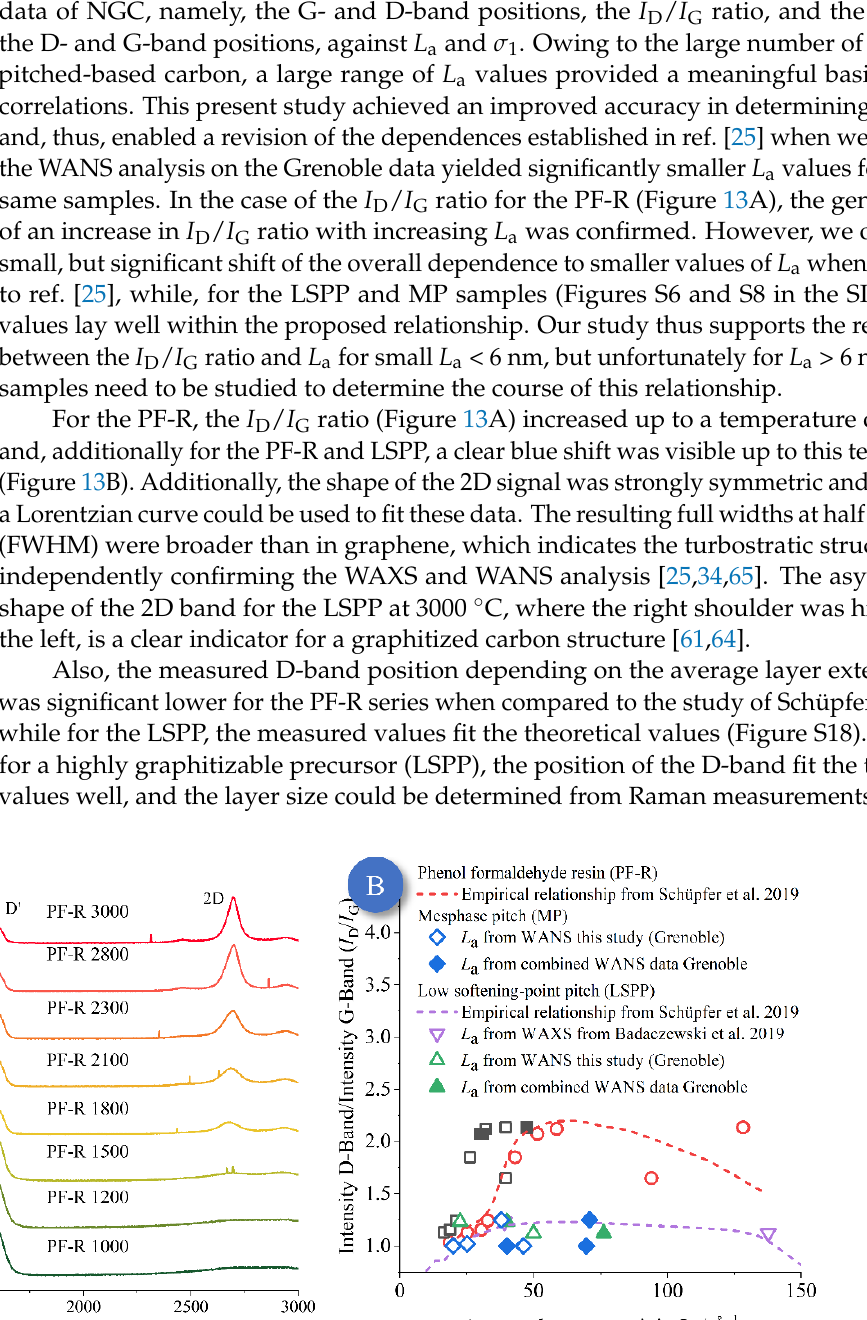
Figure 13. ( A ): Raman spectroscopy data for the phenol-formaldehyde resin-based carbons (PF-R) for different treatment temperatures, using an excitation wavelength of 633 nm. All samples showed increasing 2D and D’ bands and a higher G/D ratio at higher heat treatment temperatures, which are clear indicators for the increase in layer extension and decrease in disorder at higher temperatures [24,25]. ( B ): The intensity quotients I D / I G values were previously determined by Schüpfer et al. [25] and compared to the different L a values determined in this present study and in the work of Badaczewski et al. [37]. ( C ): The position of the D-band was lower than the theoretical values for these resins as determined in ref. [25], indicating that, for (disordered) glass-like carbon, such a theory may not be applicable. ( D ): Position of the G-band related to the L a values obtained from WAXS and WANS. Compared to the previous study of Schüpfer et al. [25], the G-band positions needed to be shifted to smaller L a . In both cases, the Campbell–Fauchet approach was used to model the data, as described by Schüpfer et al. [25,66,67]. A similar figure for the pitches can be found in the SI as Figures S17 and S18. Also, the measured D-band position depending on the average layer extension ( L a ) was significant lower for the PF-R series when compared to the study of Schüpfer et al. [25], while for the LSPP, the measured values fit the theoretical values (Figure S18). However, for a highly graphitizable precursor (LSPP), the position of the D-band fit the theoretical values well, and the layer size could be determined from Raman measurements. For the G-band position, a similar shift of the entire relationship to smaller L a was observed. (Figure 13C). Hence, this significant deviation compared to the study of Schüpfer et al. [25] implies that the underlying Campbell–Fauchet approach [66,67] might need to be modified or might not even be applicable. From Figure 13C, one can extract a